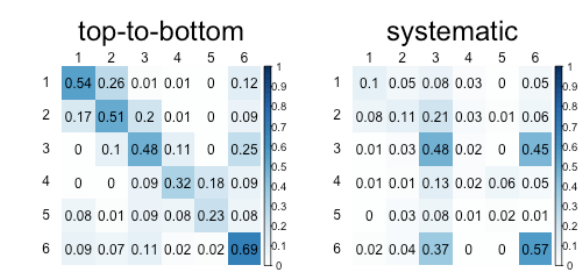
Figure 2. The average transition matrices identified by the k - means across all simulations.